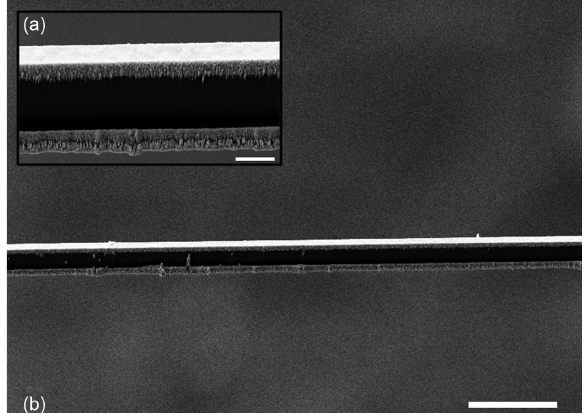
FIG. 4. SEM image of the Si 3 N 4 micro wire. (b) Example of produced wires, after the metallization (scale bar 10 μ m). (a) A detail of the structure: visible are the gold depositions on both the top and bottom parts of the wire, consisting of a thin TiAu bilayer (10 – 500 nm). The deposition parameters were set in order to reduce as much as possible the presence of gold on the lateral side of the wire (scale bar 1 μ m).